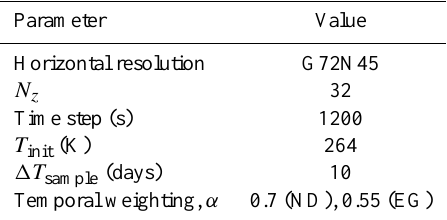
Table 3. Table showing the general parameters adopted for the cal- culations. G72N45 is notation for 144 longitude points and 90 lati- tude points and N z is the number of vertical levels. T init is the tem- perature adopted for our initial hydrostatically stable isothermal at- mosphere (as explained in Sect. 3.2.1) and 1T sample is the temporal distance between model